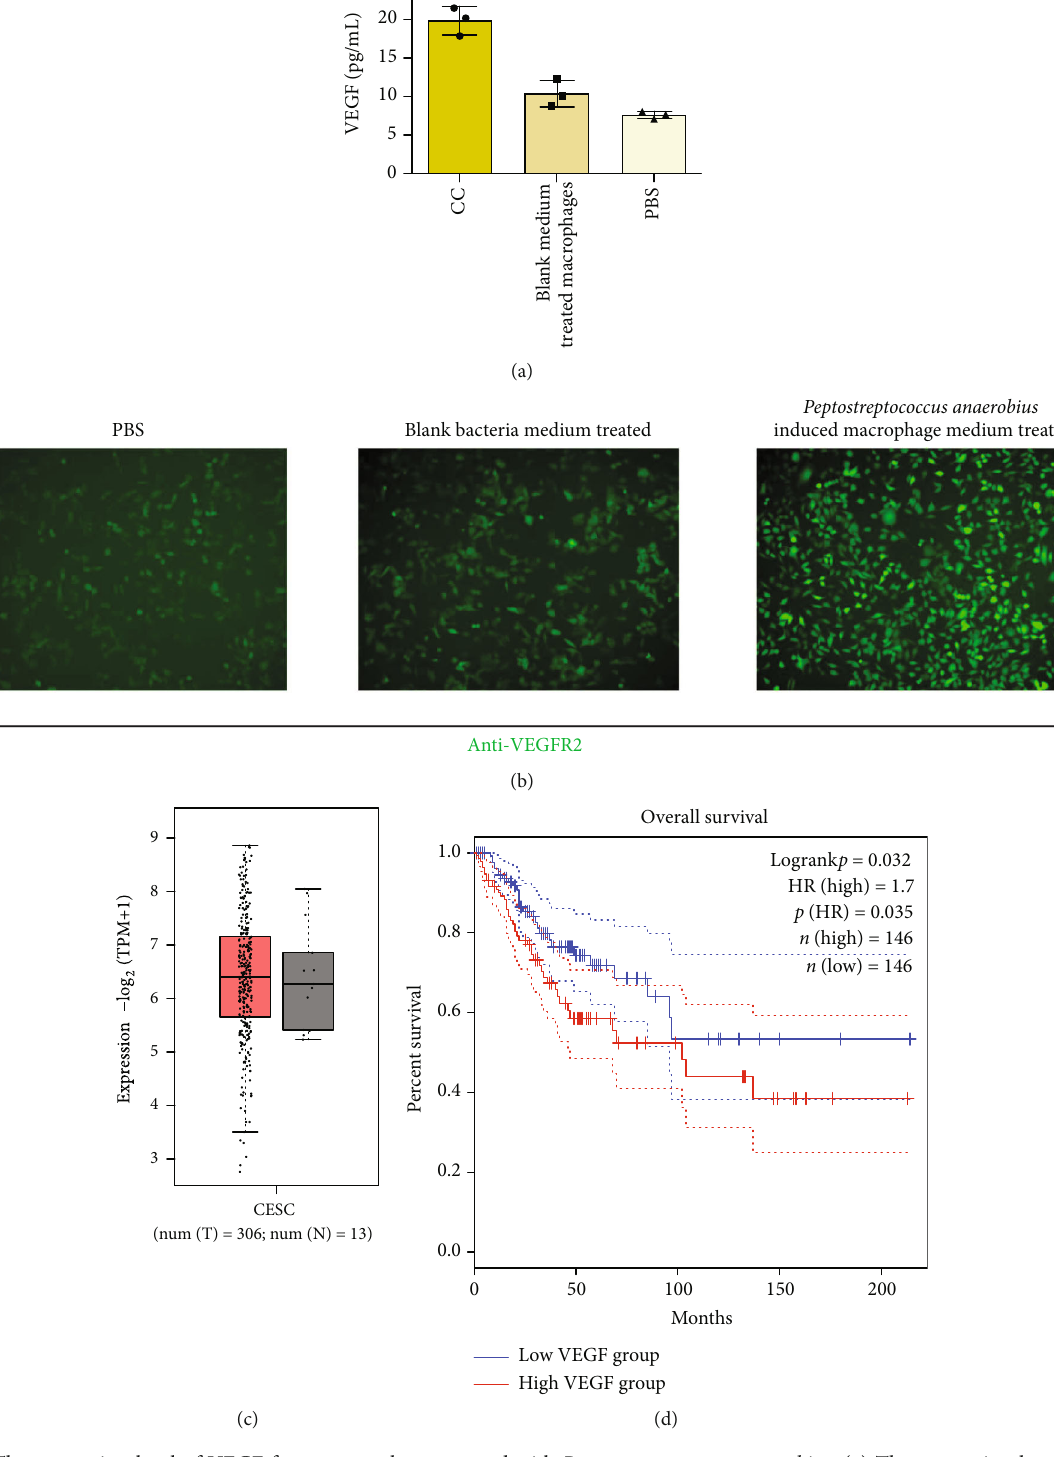
Figure 5: The expression level of VEGF from macrophages treated with Peptostreptococcus anaerobius . (a) The expression level of VEGF from macrophage medium after being treated with medium from Peptostreptococcus anaerobius -induced macrophages, blank bacteria medium-induced macrophages, and PBS. (b) The VEGFR expression on HUVECs after being treated with medium from Peptostreptococcus anaerobius -induced macrophages, blank bacteria medium-induced macrophages, and PBS. The expression analysis (c) and overall survival analysis (d) of VEGF in cervical cancer via TCGA set